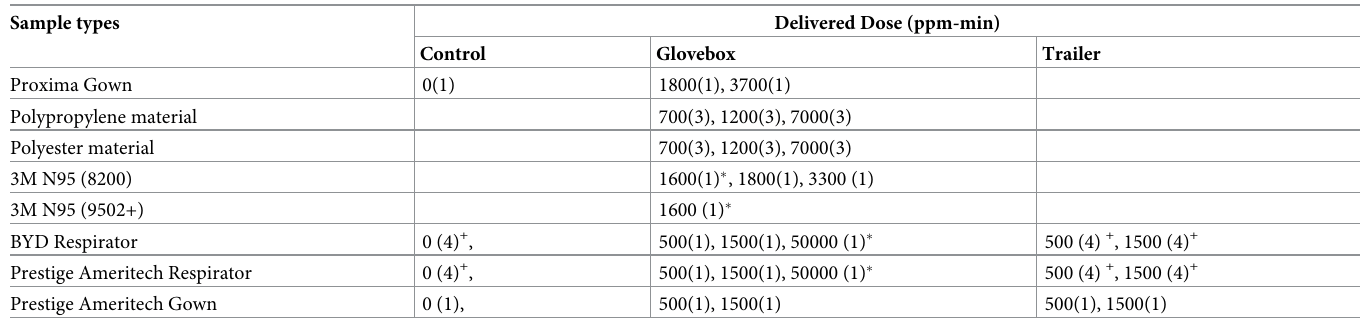
Table 4. Preparation of PPEs (intact) and material samples for the plasma ROS exposures (glovebox/trailer) and material testing. Sample